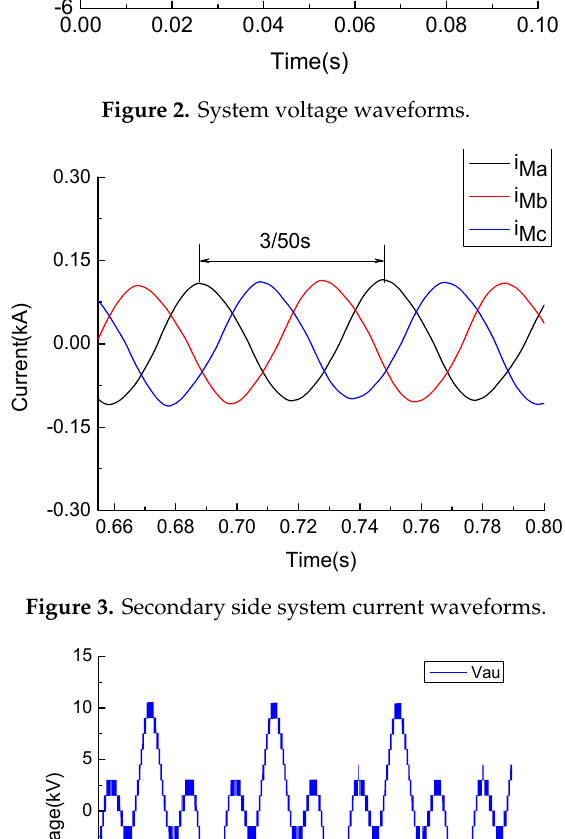
Figure 4. Module voltage waveform of branch-au.